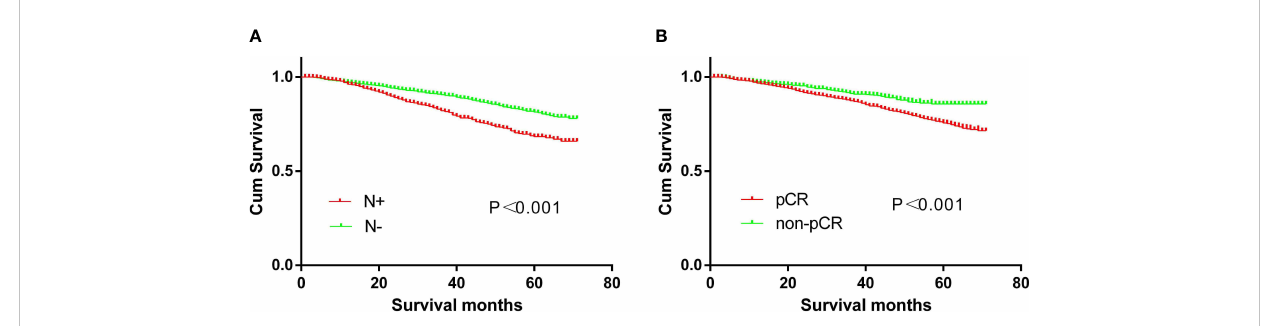
FIGURE 7 Survival curves. (A) The prognosis of CRC patients with or without N+ (p<0.01). (B) The prognosis of CRC patients with or without pCR